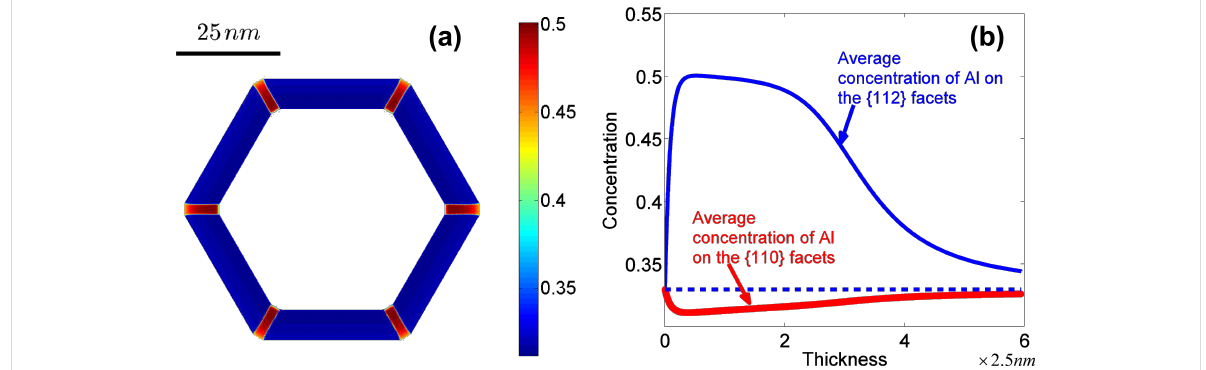
Figure 9: (a) Distribution of the concentration of Al in the shell of the nanowire. (b) Evolution of the average concentration of Al on different facets versus the thickness of the shell (in the direction normal to {110} facets).